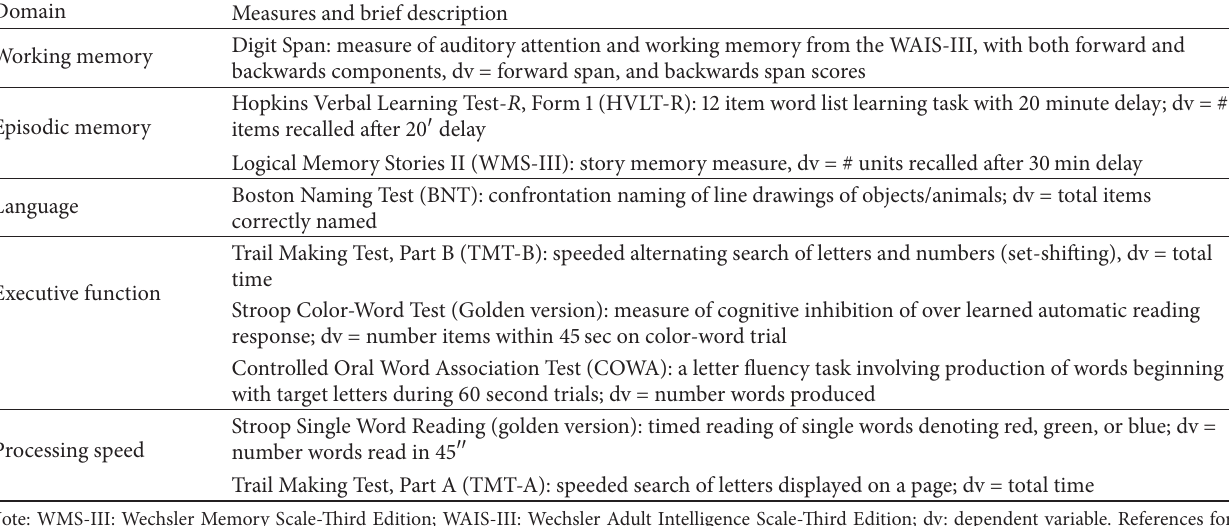
Table 1: Cognitive domains.